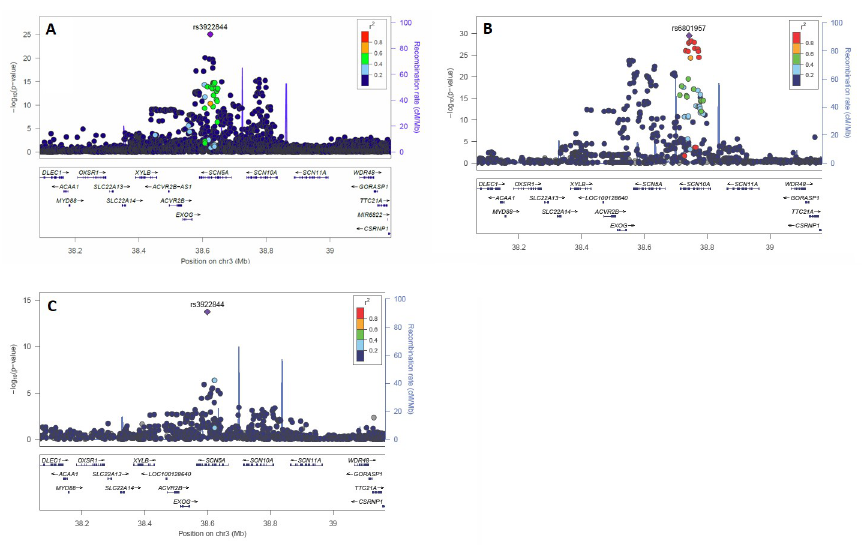
Fig 3. Regional association plots of SCN5A-SCN10A . A (top-left)–Hispanic/Latino GWAS. B (top right)–European GWAS. C (bottom left)–African American GWAS. Plots created with LocusZoom software.[20] The most